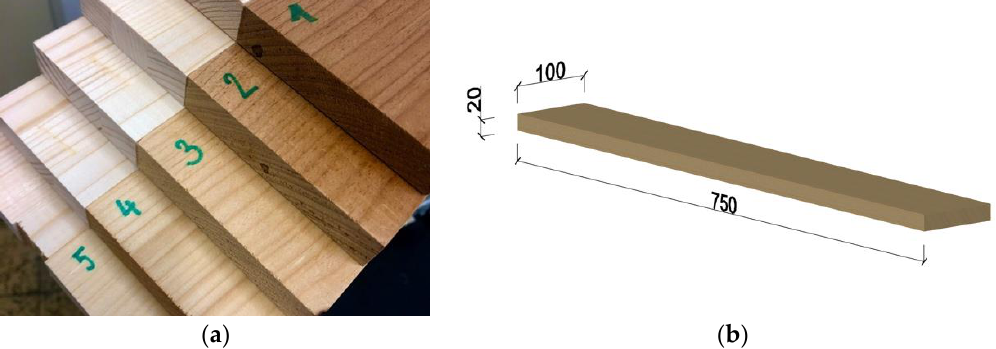
Figure 1. ( a ) (1) temperature 220 °C; (2) temperature 200 °C; (3) temperature 180 °C; (4) temperature 160 °C; (5) a reference sample without TM, ( b ) dimensions of the sample .